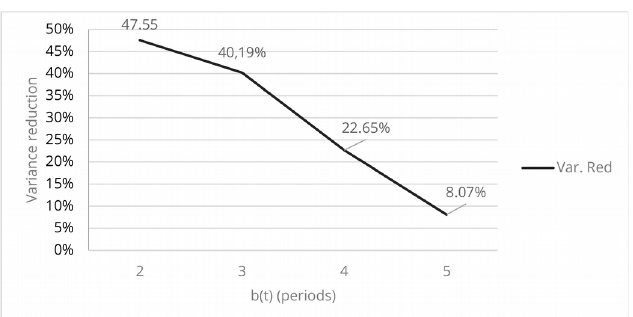
Figure 3. Effects of interruption time to variance reduction